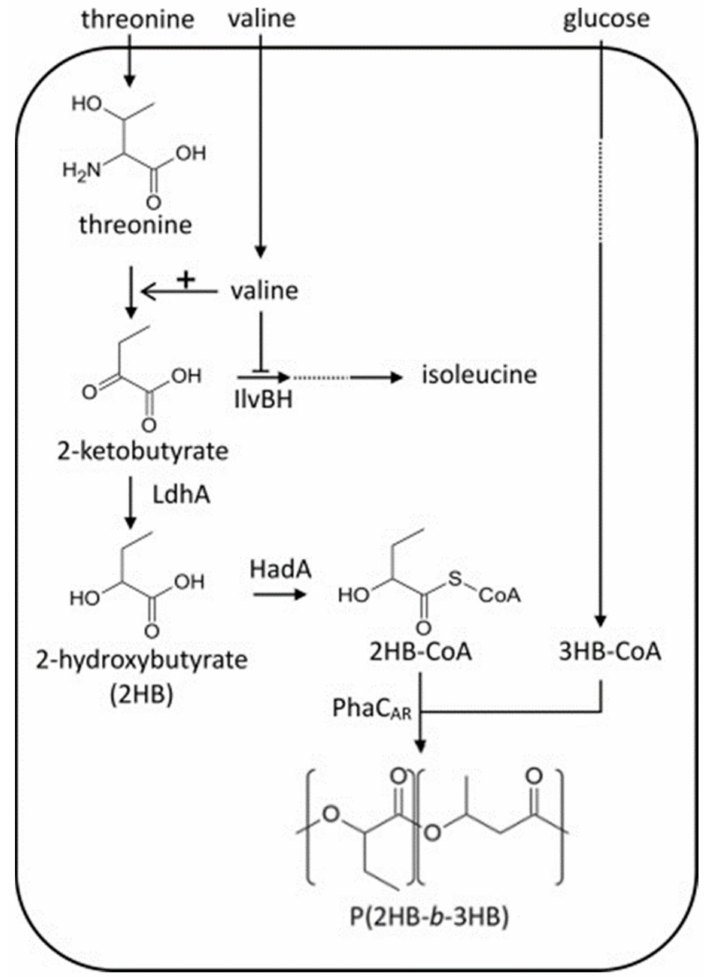
Figure 6. Poly(2-hydroxybutyrate-b-3-hydroxybutyrate) (P2HB-b-P3HB) biosynthesis pathways in engineered E. coli with amino acid supplementation. Amino acids are also supplied through the endogenous pathways. Reproduced with permission from [113]. Copyright 2020 Elsevier